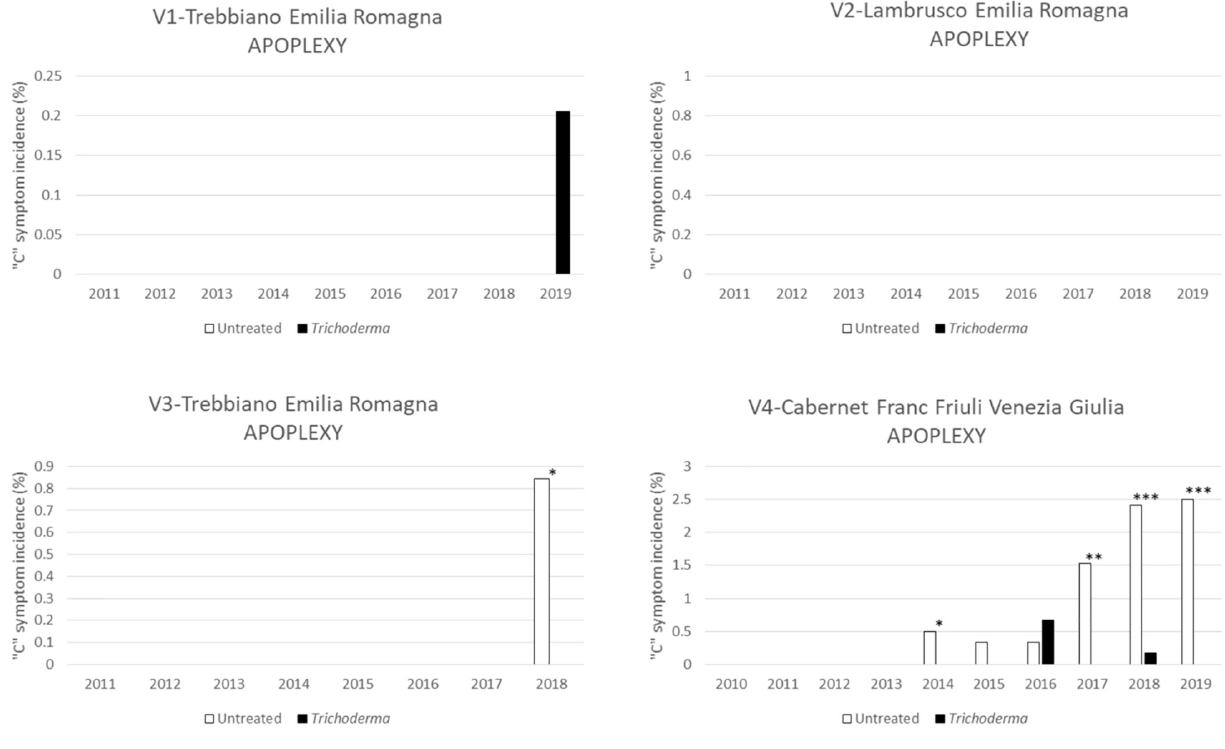
FIGURE 6 | Apoplexy symptoms in the four young asymptomatic vineyards monitored for 8–10 years were analyzed by χ 2 test. All the plants of each plot were considered to compare Trichoderma and control treatments. Where differences in distribution between the two treatments were significant, asterisks were placed ( ∗ P < 0.05, ∗∗ P < 0.01, and ∗∗∗ P < 0.001 significance levels,